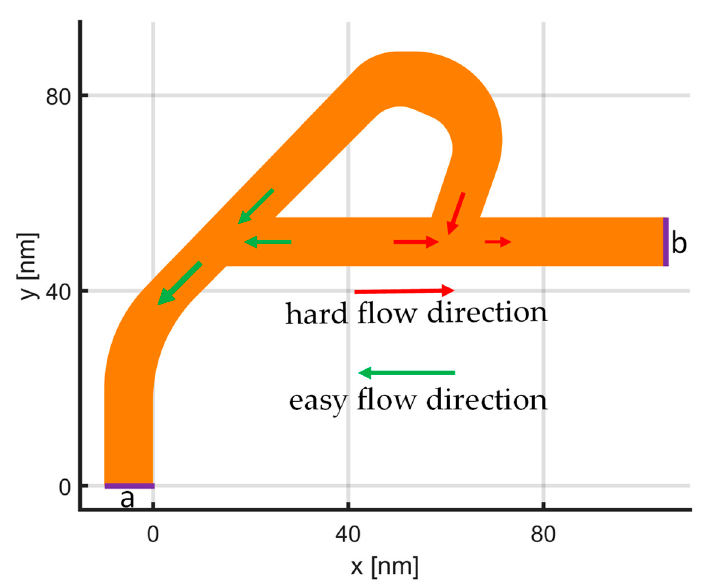
Figure 2. Geometry of 2-D graphene Tesla valve. The orange area is the full 2-D computation domain. Ohmic contacts are depicted with “a” and “b”, the charge carriers flow depending on the applied potential, either from “a” to “b” or from “b” to “a”. The boundaries are insulating, except for the ohmic-metallic contacts. Hard and easy flow directions are given by the